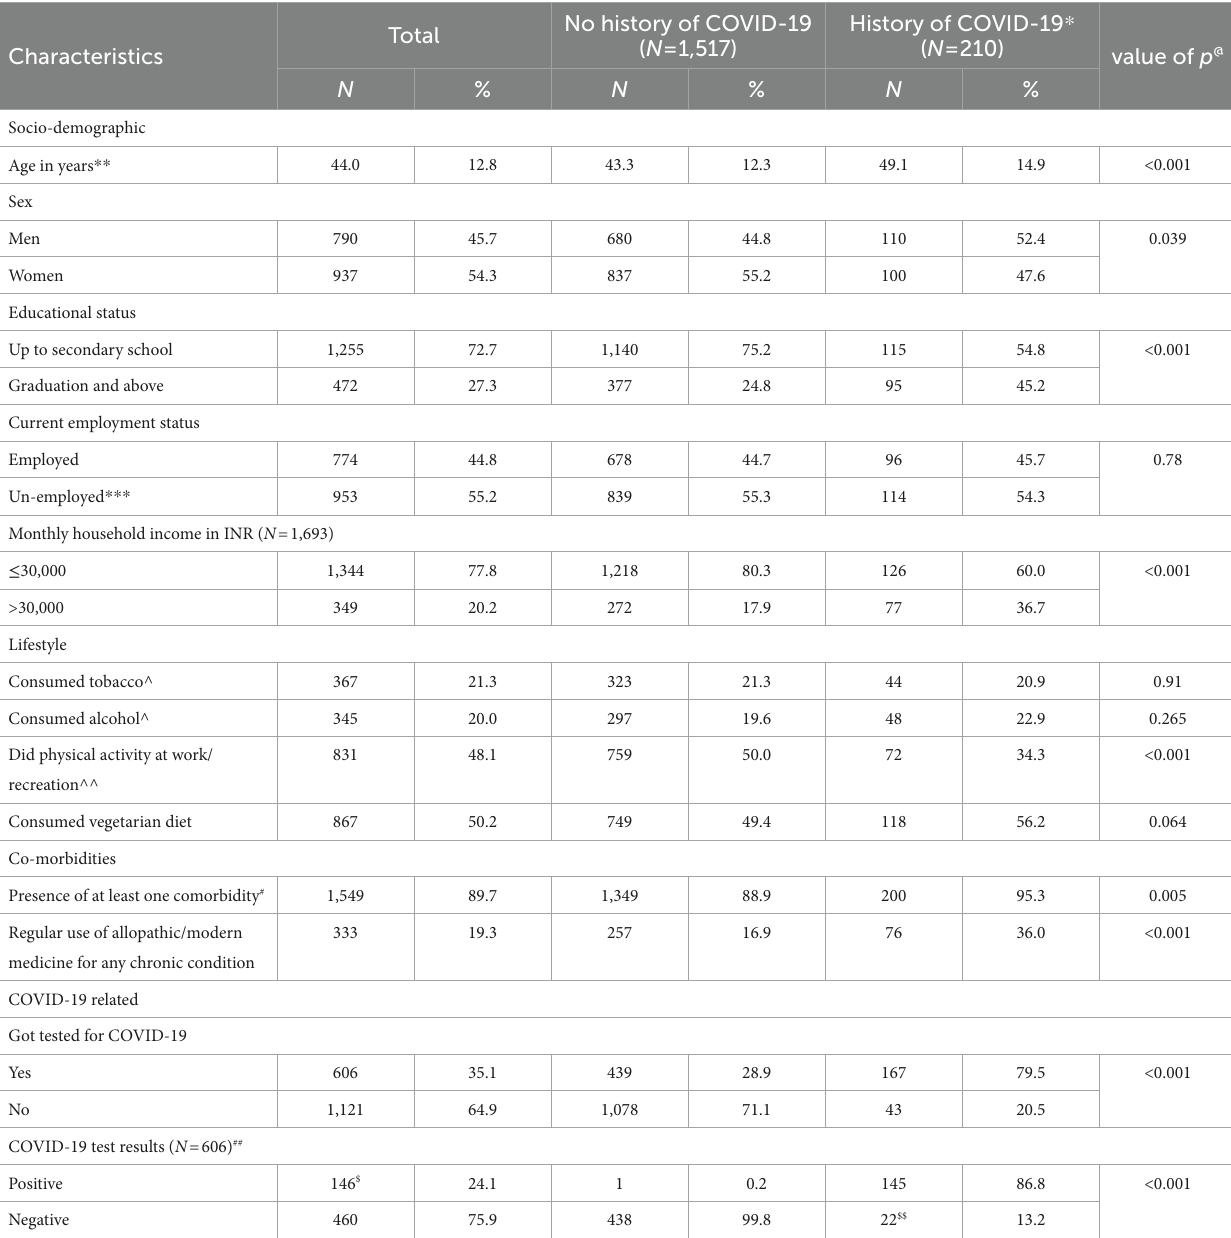
TABLE 2 Baseline characteristics (2016–2018) of study participants ( N = 1,727) by history of COVID-19 at follow-up (2021–2022).